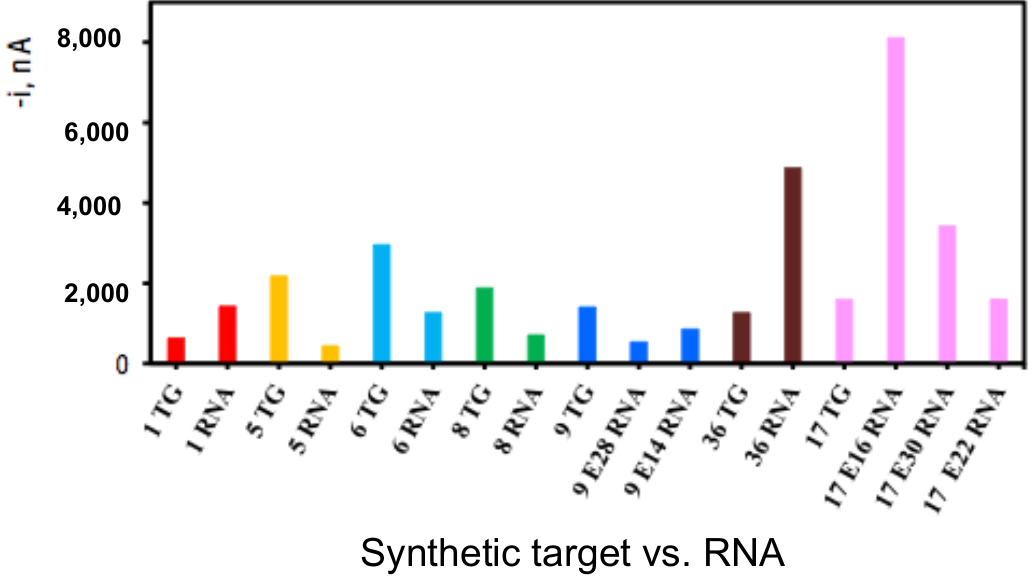
Figure 4. Comparison of 100 pM of synthetic target (TG) with 100 pM of RNA from selected probes where RNA was available. Multiple RNA extractions from di ff erent strains of the same species